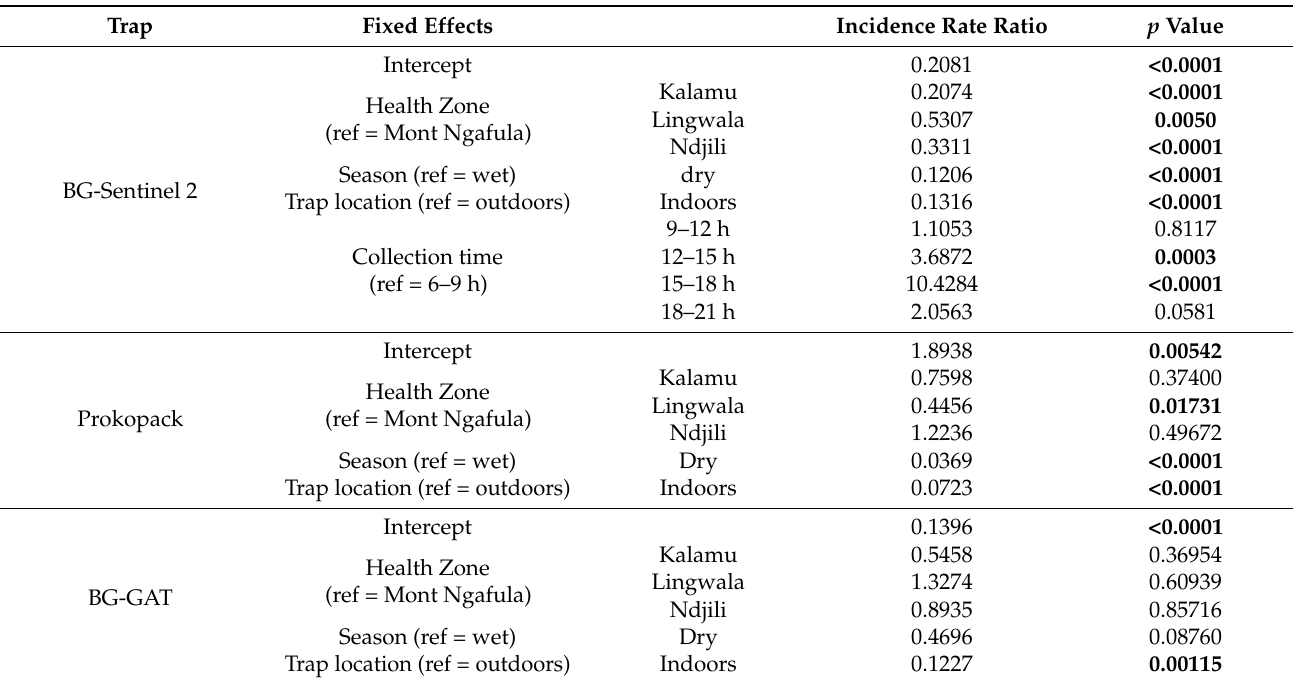
Table 2. The effect of commune, season (survey), place of collection, and time of collection on the collection of female Aedes aegypti based on a GLM with negative binomial distribution. p Values lower than 0.05 are highlighted in